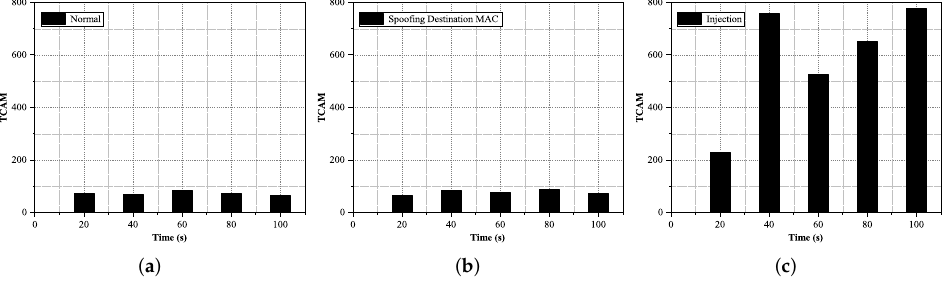
Figure 6. Attack impact on OpenFlow switch. ( a ) Normal. ( b ) Spoofing Destination MAC. ( c )